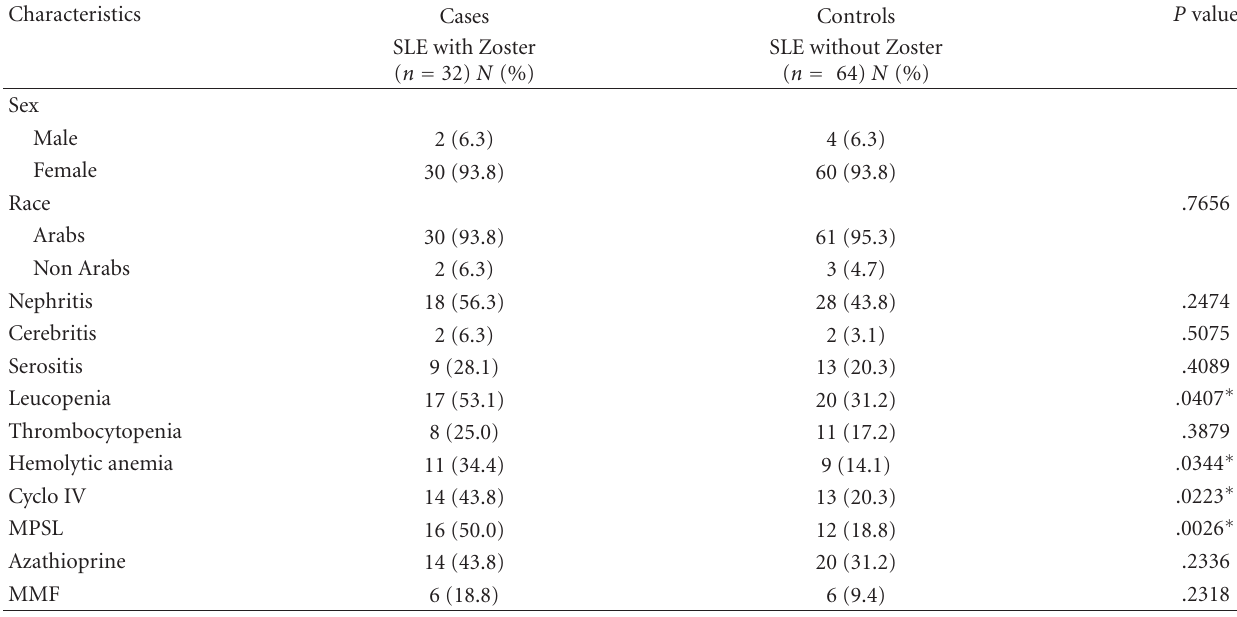
Table 1: Comparison of demographic and clinical features in SLE Zoster and SLE Non-Zoster